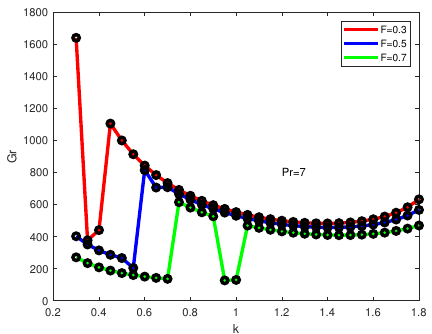
Figure 9. Marginal stability curves for Pr = 7 (Case 1).